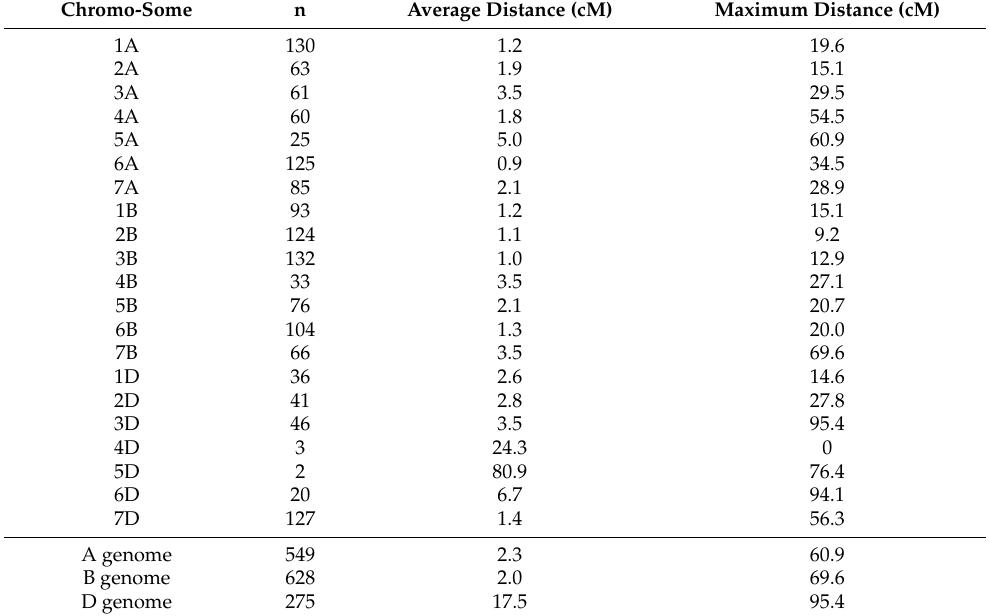
Table 2. Distribution of 1452 polymorphic DArT markers ordered by chromosomes. The chromosome name, the number n of markers per chromosome, the average distance between markers and the maximum distance between two markers are indicated. Summaries for the A, B and D genomes are given at the bottom.